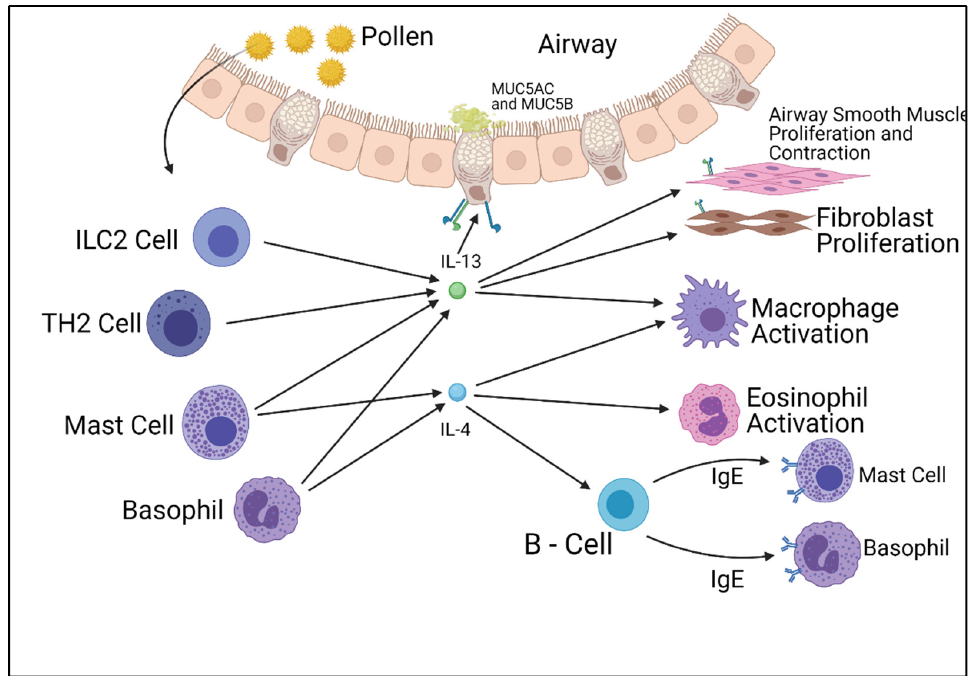
Figure 1. Summary of the cells responsible for the production of IL-4 and IL-13 and their effects on other cell types. Figure was created by the authors and reproduced with permission from BioRender.com (accessed on 19 November 2021).